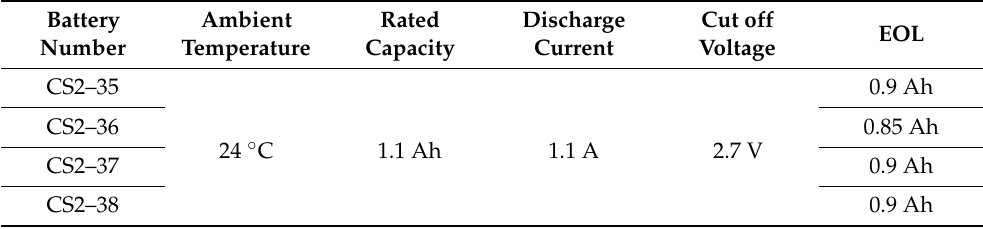
Table 1. Use of battery data parameters.